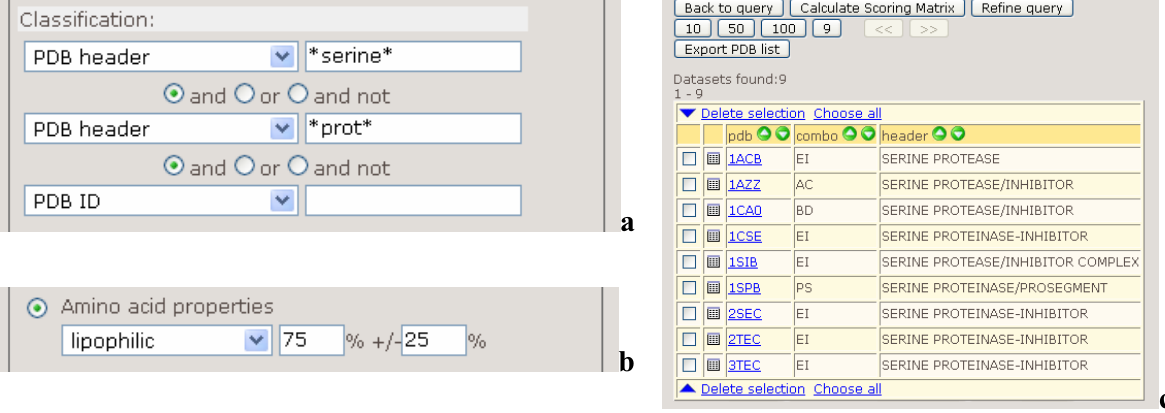
Figure 4: (a), (b) show excerpts of the search form that are related to the query example described in the text. The resulting list of hits is shown in